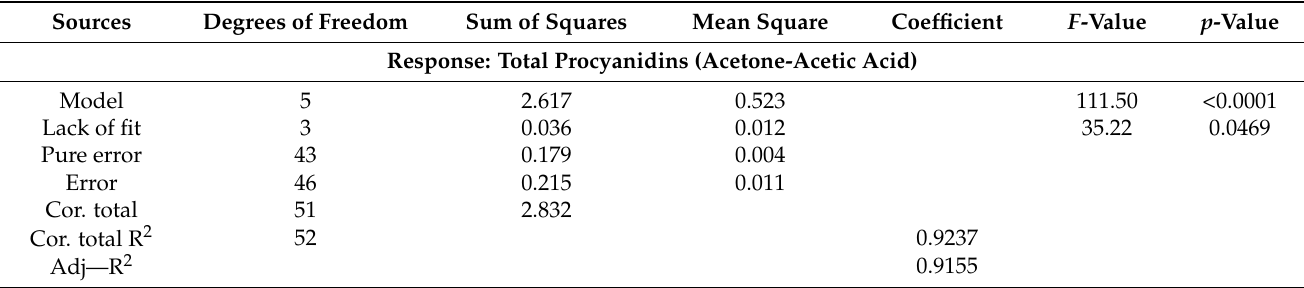
Table 6. Analysis of variance (ANOVA) for the response surface models on the total procyanidin yield from American cranberry press